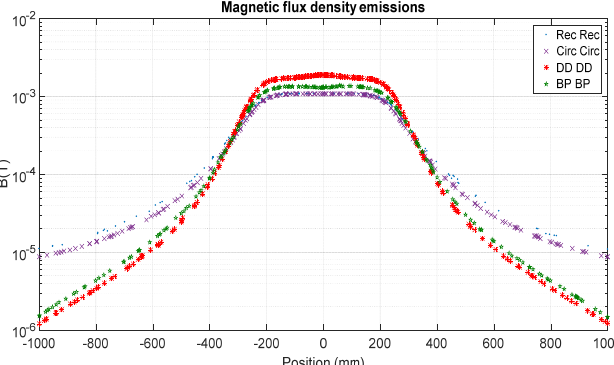
Figure 16. Electromagnetic induction norm B (T) along red axis of Figure 15.